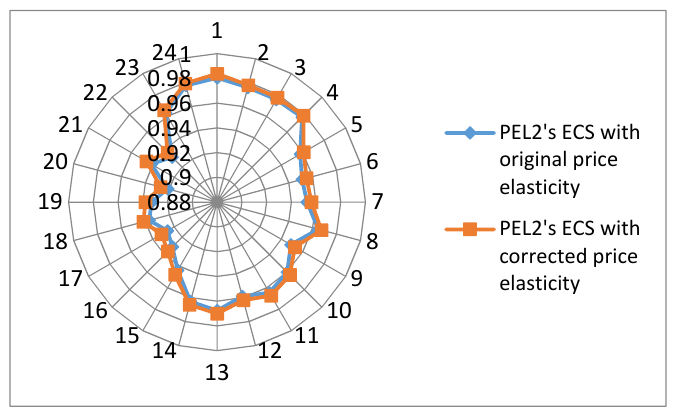
Figure 9. Electricity consumption satisfaction (ECS) of PEL 2 with changing α .